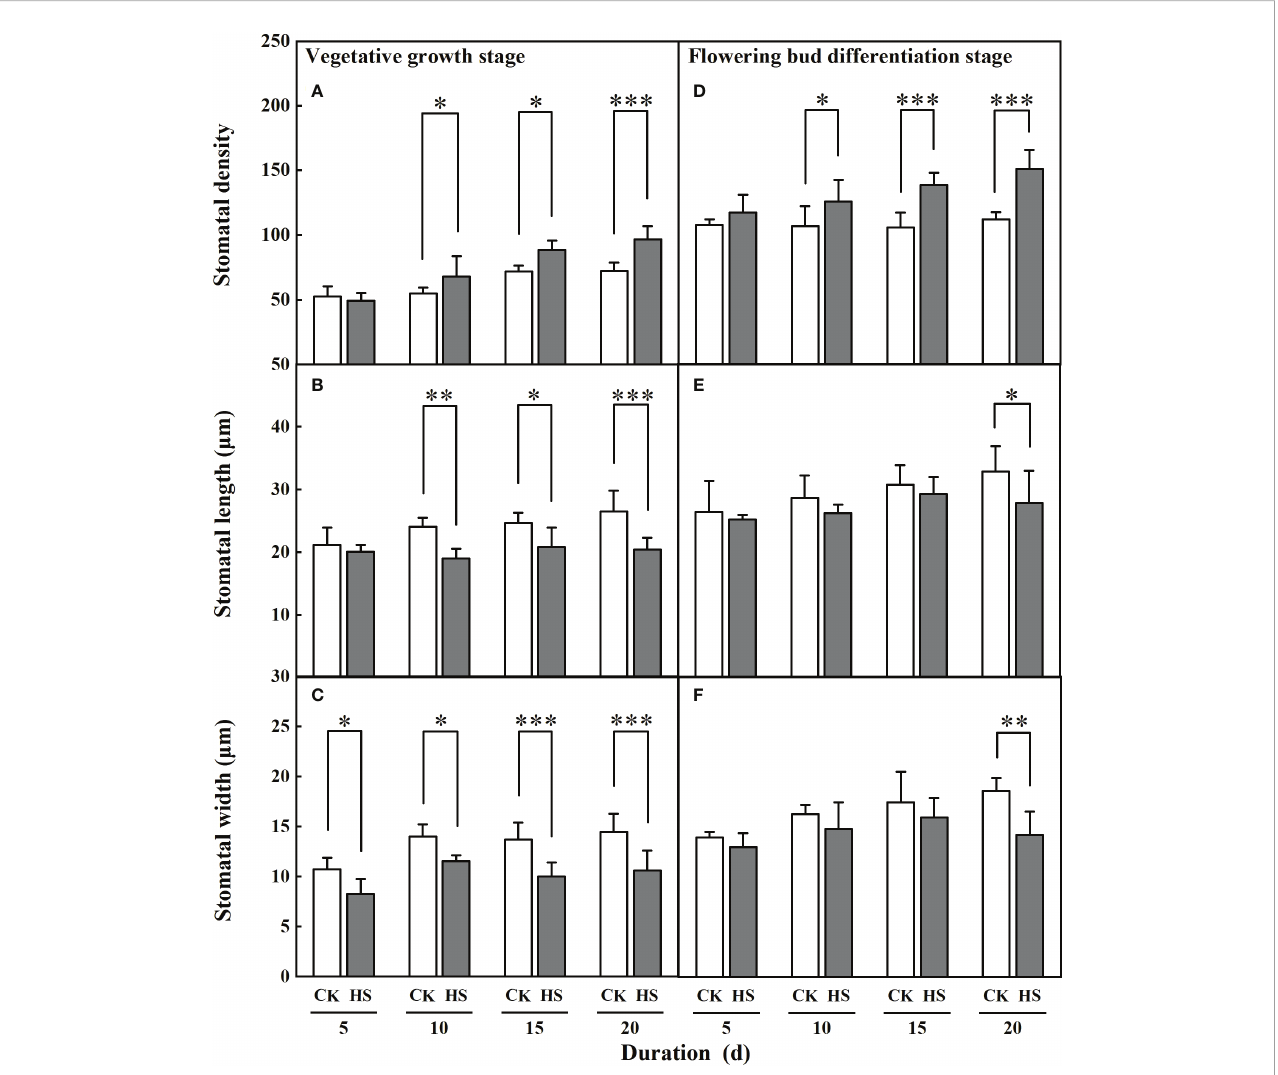
FIGURE 4 Response of stomatal density (A, D) , length (B, E) and width (C, F) of gerbera to heat stress (HS) during vegetative growth (A – C) and fl owering bud differentiation stages (D-F) . CK is the control treatment. Values are the mean ± SD (n=5). *, **, and *** represent the signi fi cant level at P <0.05, P <0.01, and P <0.001,